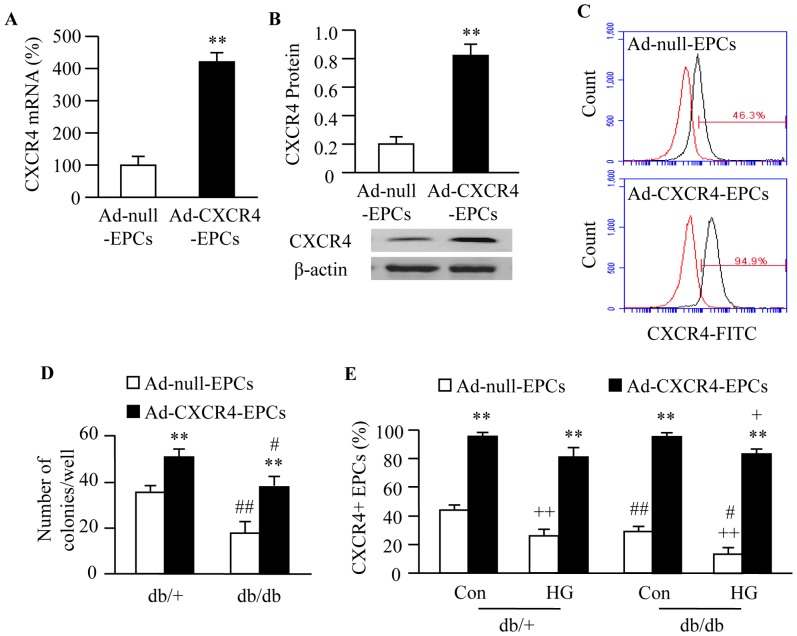
CXCR4 expression and colony forming capacity of EPCs.CXCR4 mRNA expression (A) and protein expression (B) in EPCs after Ad-CXCR4 transfection. (C) Representative histogram distributions of flow data showing the percentage of CXCR4+ EPCs in Ad-null-EPCs and Ad-CXCR4-EPCs. The red line is the IgG isotype control. (D) Summarized data on the colony forming units of EPCs. (E) Summarized data showing the expression of CXCR4 in EPCs from both db/+ and db/db mice with or without HG (25 mM) treatment. **P<0.01 vs. Ad-null-EPCs; +
P<0.05, ++
P<0.01 vs. Con; #
P<0.05, ##
P<0.01 vs. db/+, n = 6/group. Con: control (basal medium); HG: high glucose medium; Ad-null-EPCs: EPCs transfected with Ad-null; Ad-CXCR4-EPCs: EPCs transfected with Ad-CXCR4.